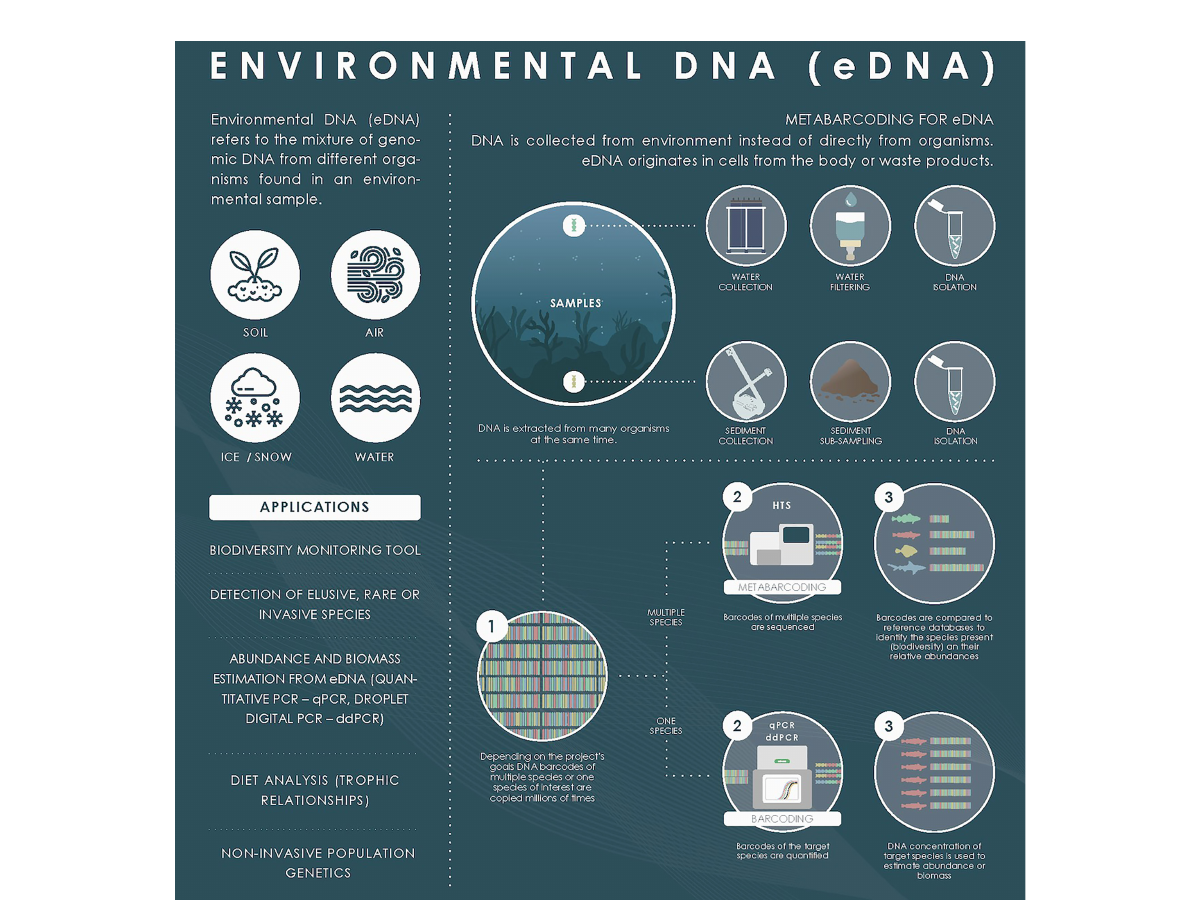
FIGURE 2 Scheme of eDNA used in the FishGenome contract virtual workshop “ Improving Cost-Ef fi ciency of Fisheries Research Surveys and Fish Stocks Assessments using Next-Generation Genetic Sequencing Methods ” . The de fi nition, applicability and methodology of eDNA from samples collected from sediment and seawater are